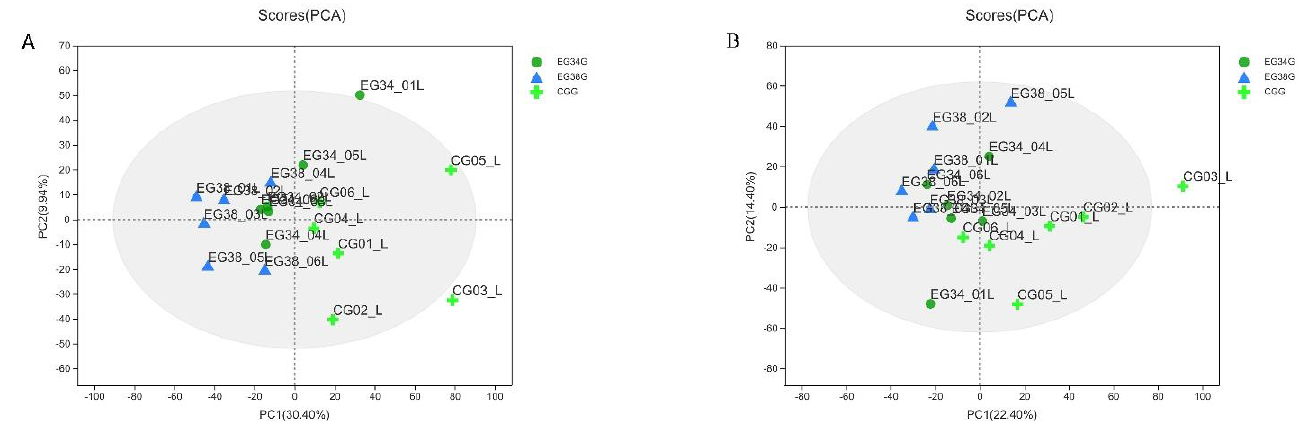
Figure 3. PCA score plot for samples from the treatment and QC groups: ( A ) ESI+; ( B ) ESI − .